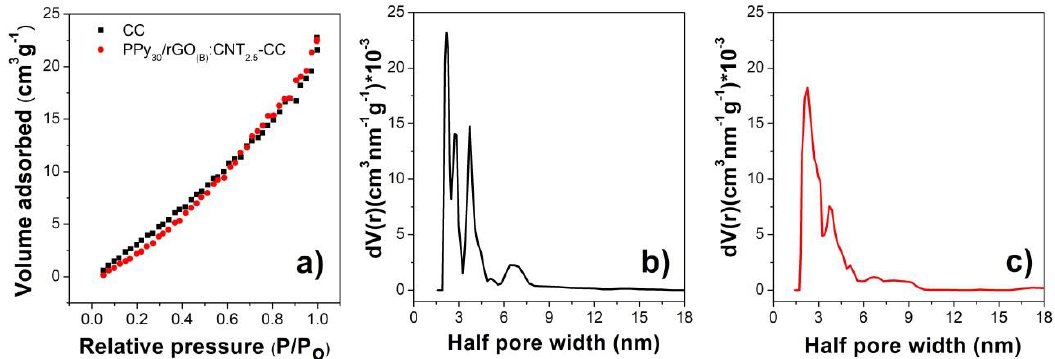
Figure 4. Nitrogen sorption analysis ( a ) of activated CF substrate before and after coating with PPy/rGO:MWCNT and corresponding pore size distribution by density functional theory (DFT) method ( b , c ).